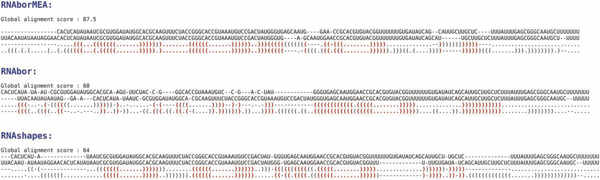
Given riboswitch sequence X83878/168-267 and initial structure S0, the minimum free energy structure, a structure output by RNAborMEAis most structurally similar to the XPT GENE ONstructure, as measured by NestedAlign[36]. The NestedAlign score for RNAborMEA is 87.5, while optimal score for RNAbor is 60.0, and for RNAshapes is 64.0.